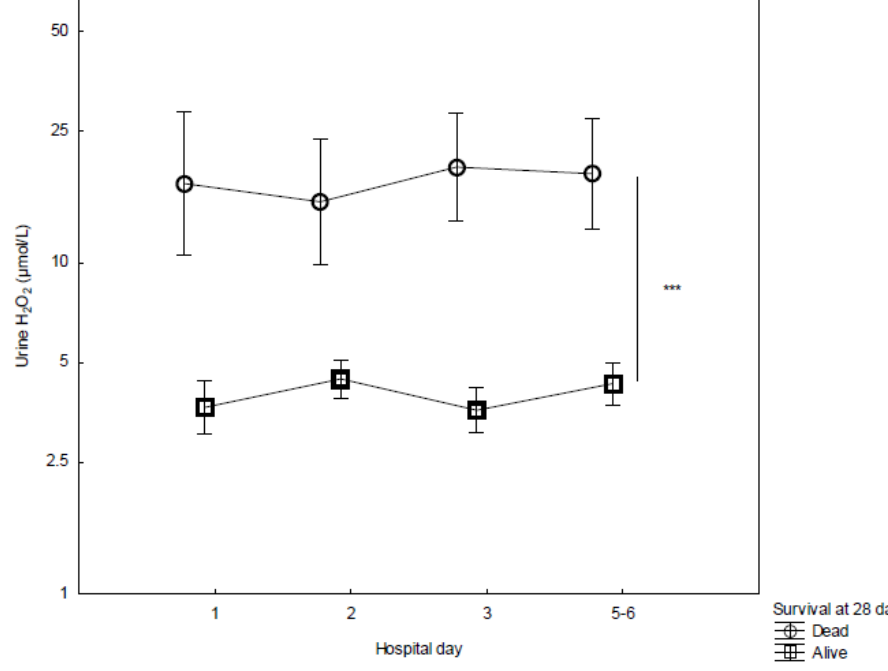
Figure 2. Concentrations of urine H 2 O 2 from admission (day 1) to day 5–6 in the ICU, stratified by survivors ( n = 71) and non-survivors ( n = 11). ANOVA III for repeated measures was used to assess differences over time. Mean ± SEM. *** p < 0.001.